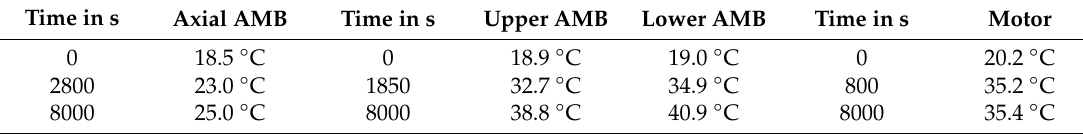
Table A3. Measured stator temperature during cycling with a bias current of 4